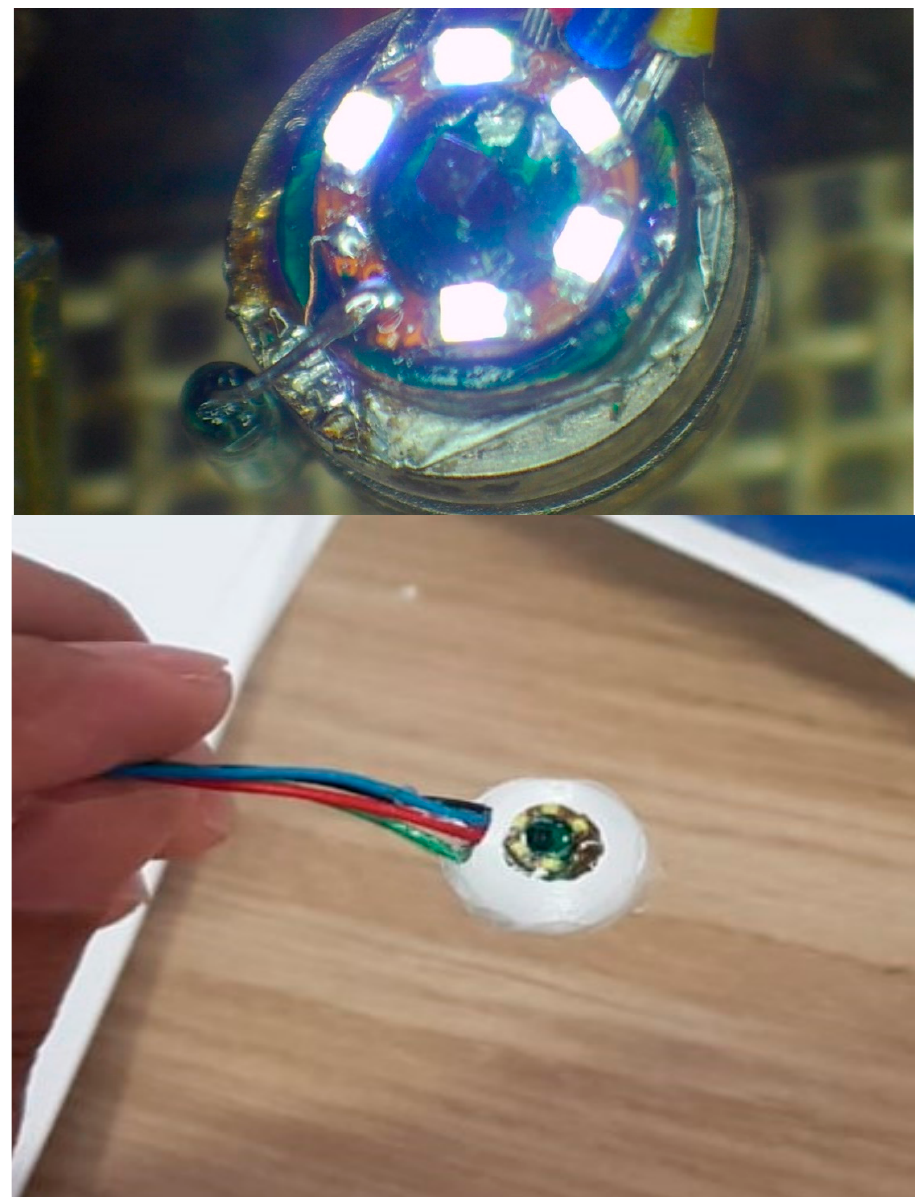
Figure 10. Image after installing all components and before and after the outer cover .